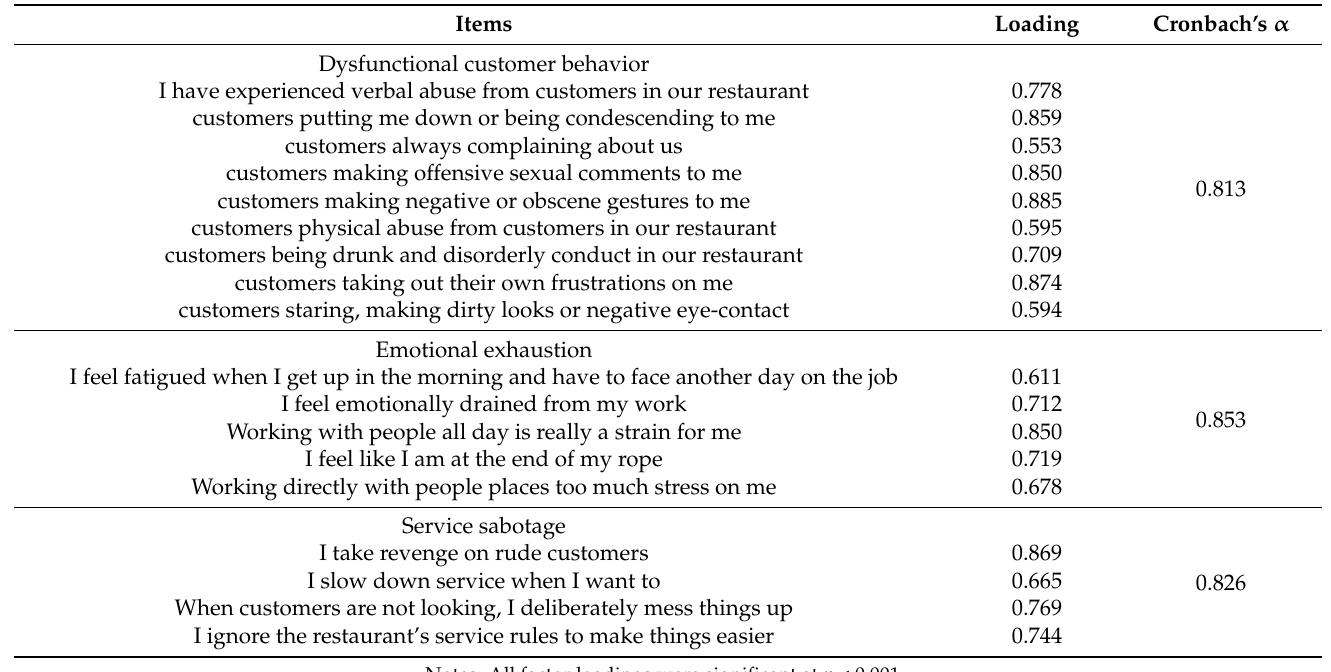
Table 2. Confirmatory factor analysis: Items and